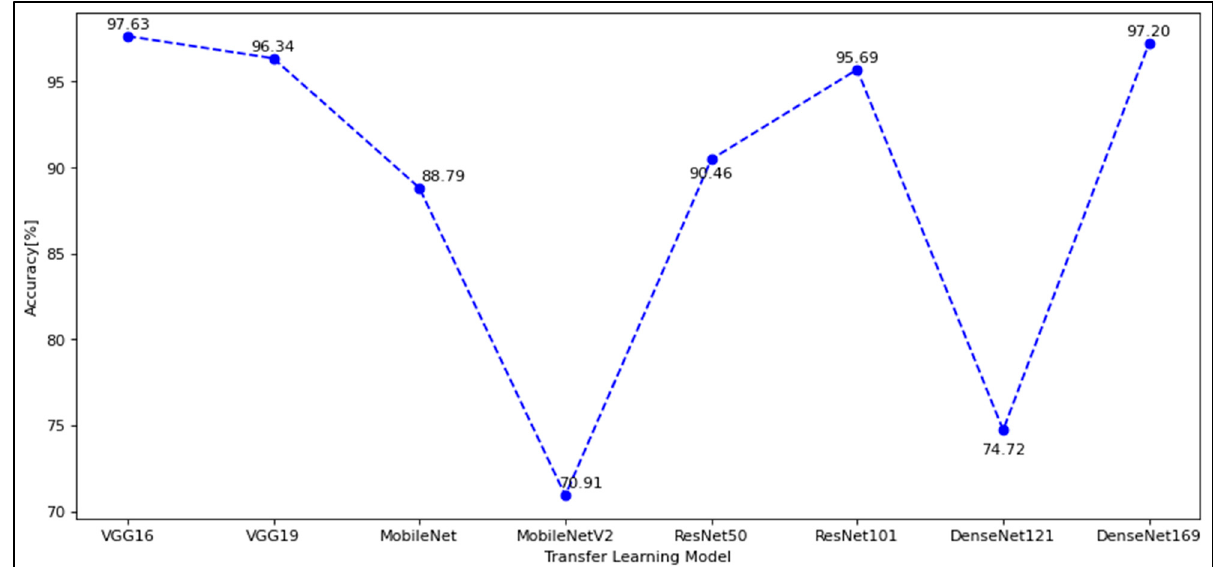
Figure 10. Validation of pre-trained model accuracy on a 224-image